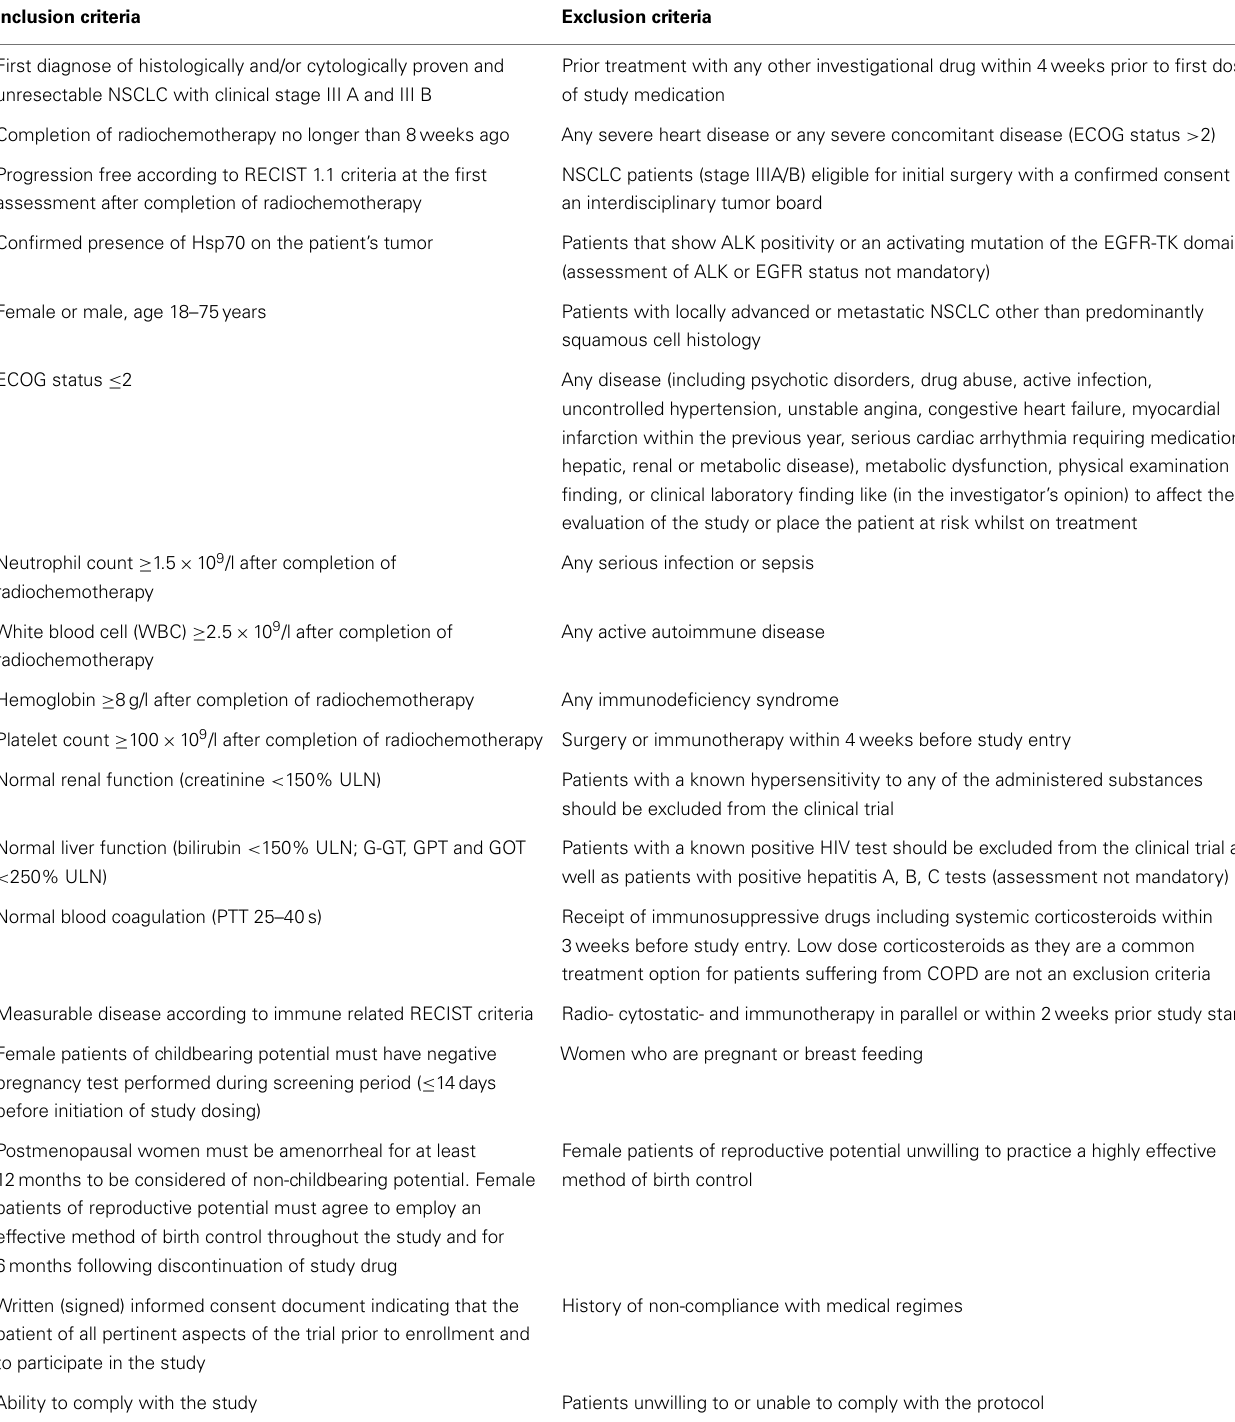
Table 1 | In- and exclusion criteria of the ongoing phase II clinical trial: targeted NK cell-based adoptive immunotherapy for the treatment of patients with non-small cell lung cancer (NSCLC) after radiochemotherapy